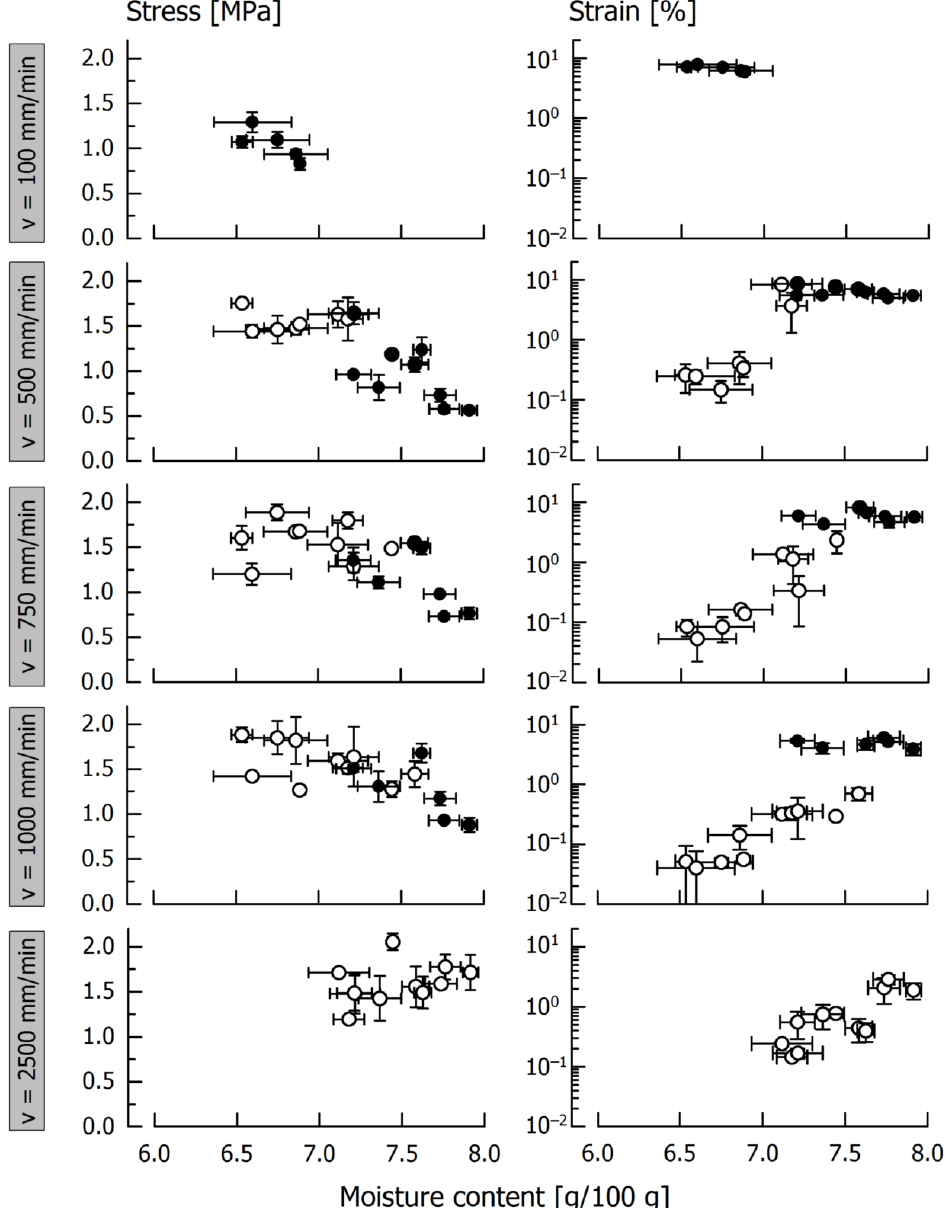
Figure 4. Fracture stress σ f (open circles) and tensile strength R m (closed circles) as well as fracture strain ε f (open circles) and maximum plastic elongation ε p (closed circles) of caramels subjected to tensile testing at different velocity. Data are arithmetic means ± standard deviation for fracture stress or tensile strength and the corresponding strain ( n = 3), and moisture ( n =